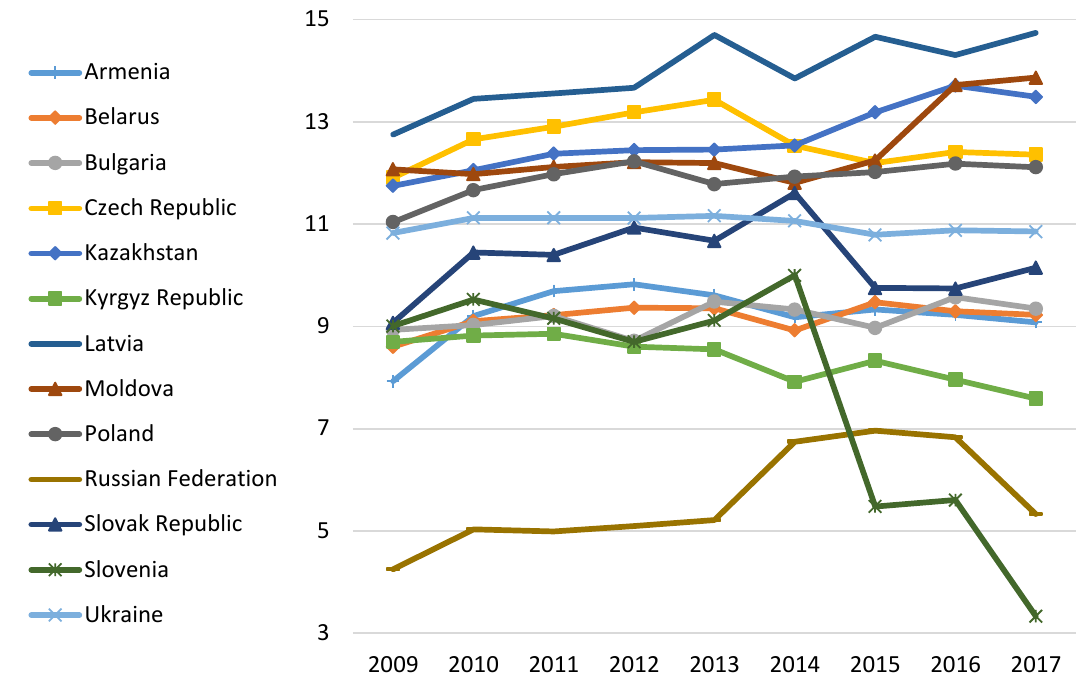
Figure 2. Adjusted net savings (% of GNI), simulated